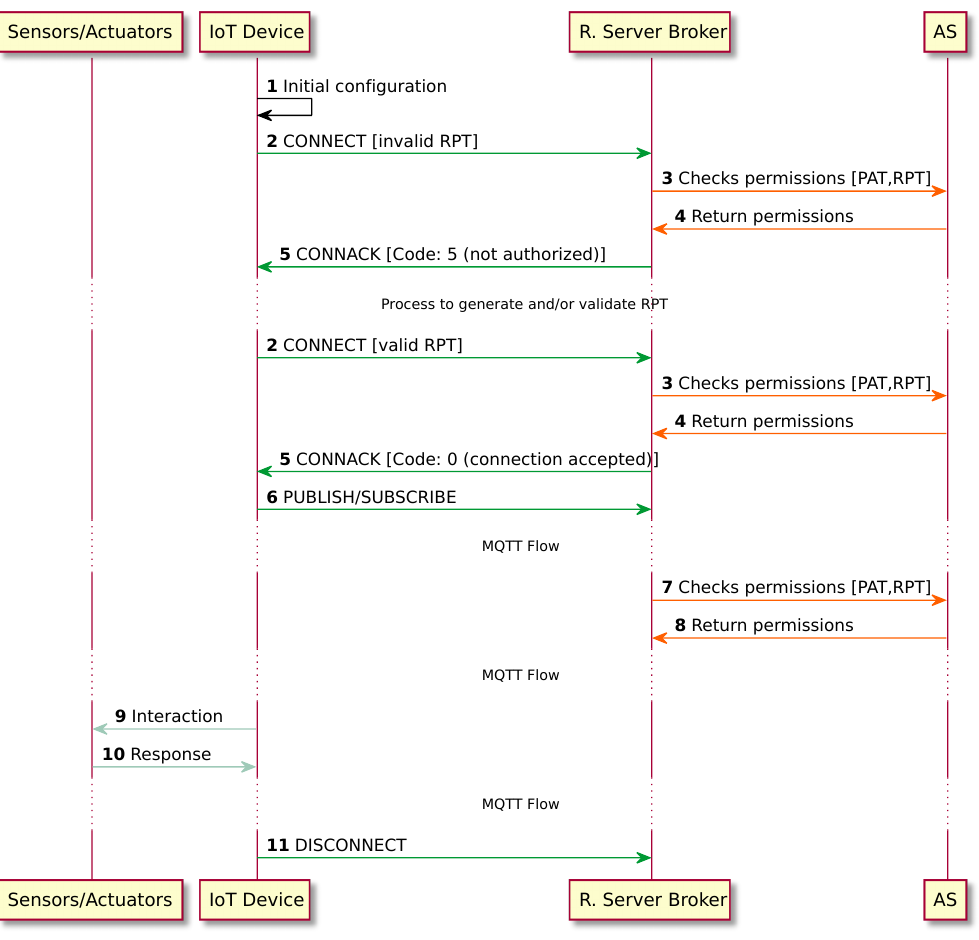
Figure 4. Sequence diagram for accessing the protected Message Queue Telemetry Transport (MQTT)